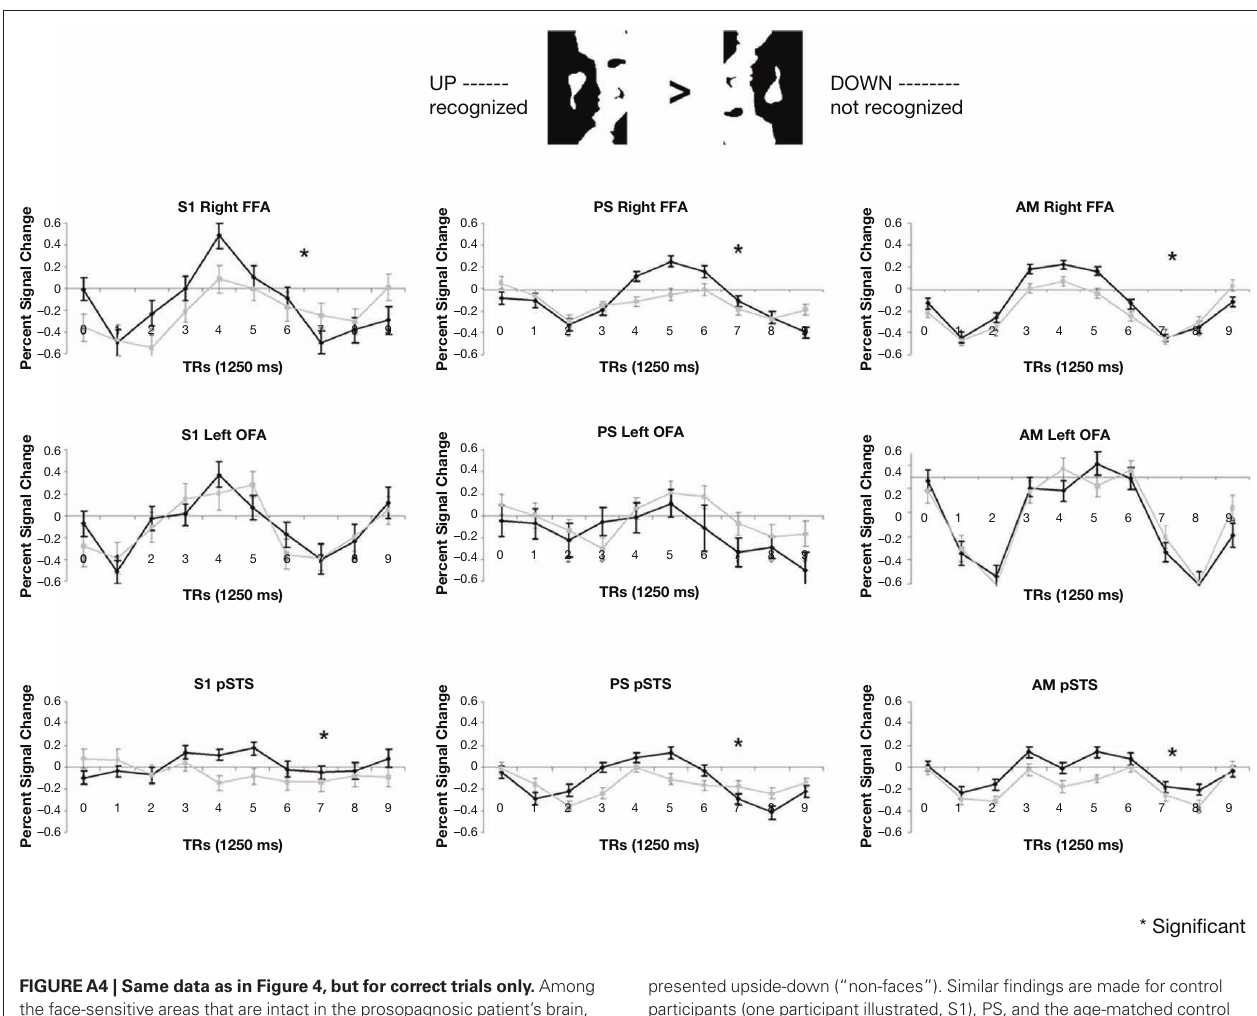
Figure A4 | Same data as in Figure 4, but for correct trials only. Among the face-sensitive areas that are intact in the prosopagnosic patient’s brain, only the right FFA, and pSTS to a lesser extent, showed a larger response to Mooney stimuli perceived as faces as compared to the same pictures